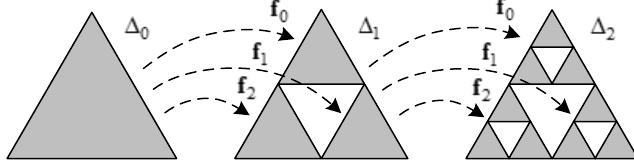
Figure 3. The example of acquiring the designed shape through two iterations of the procedure.